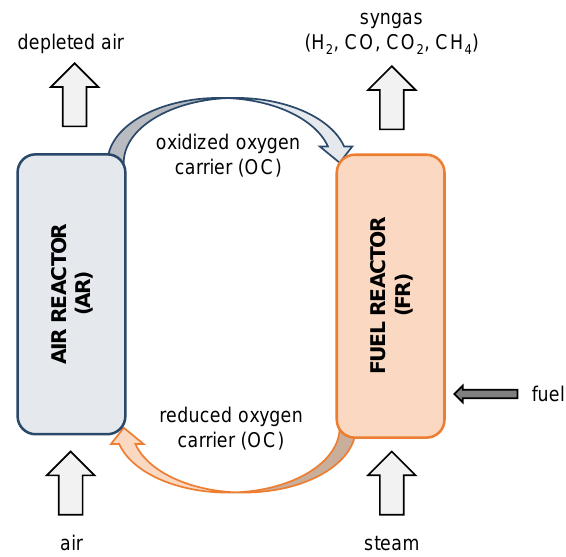
Figure 1. Schematic illustration of a CLG